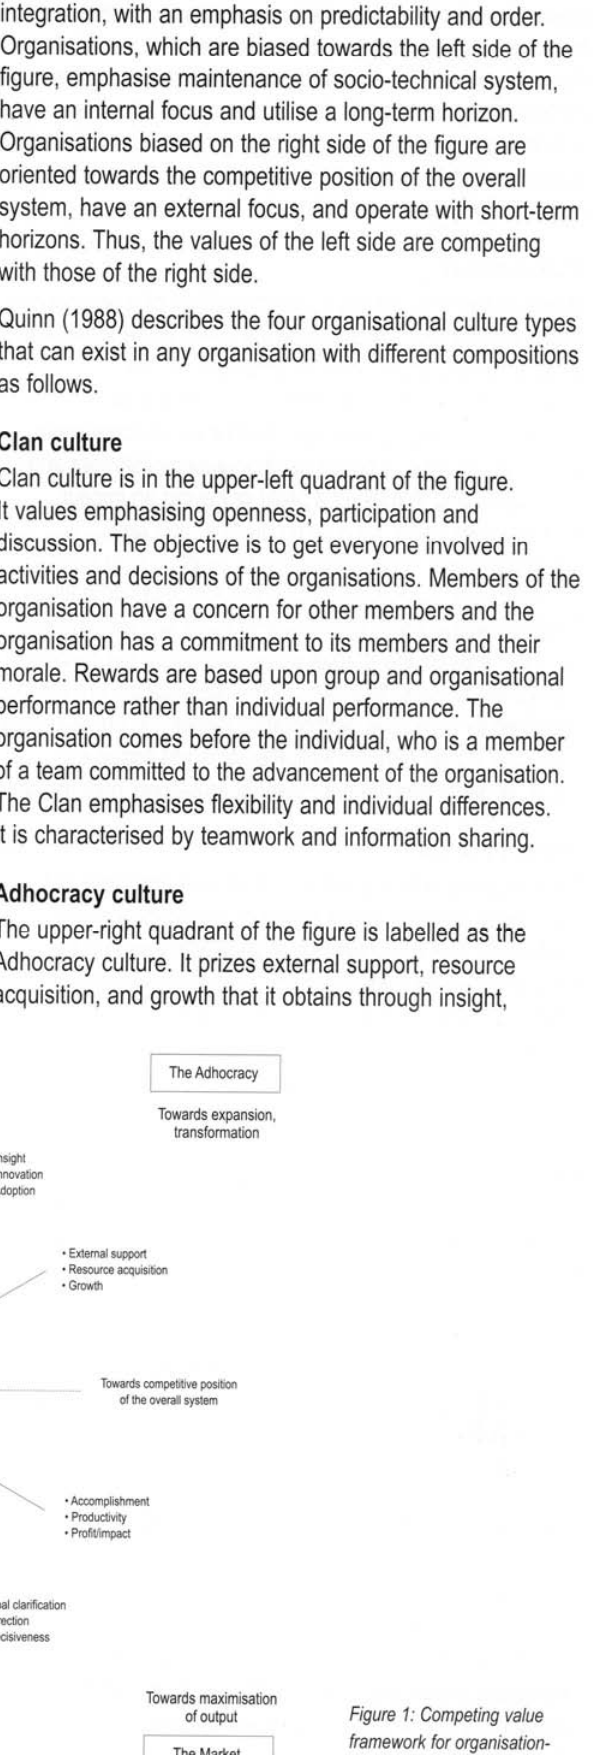
Figure 1.' Competing